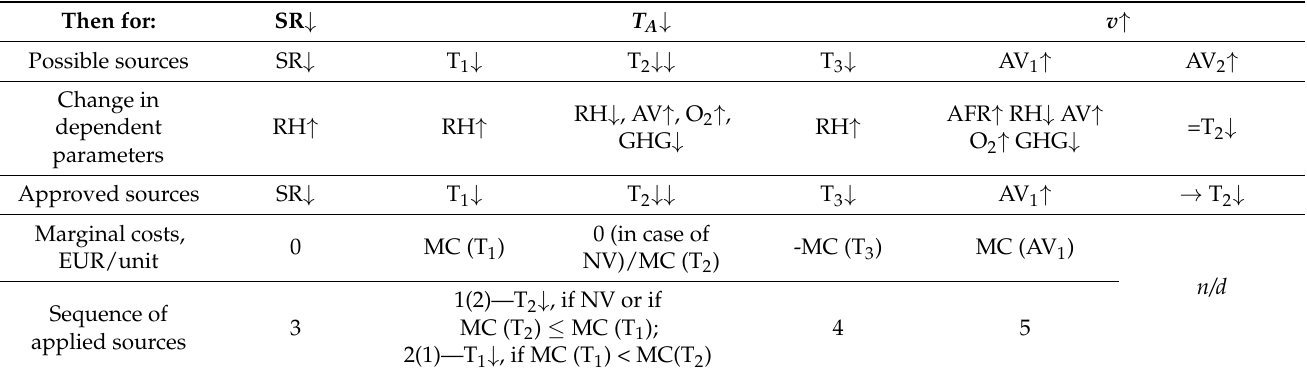
Table 7. Algorithm in a sequence for applying measures to regulate the